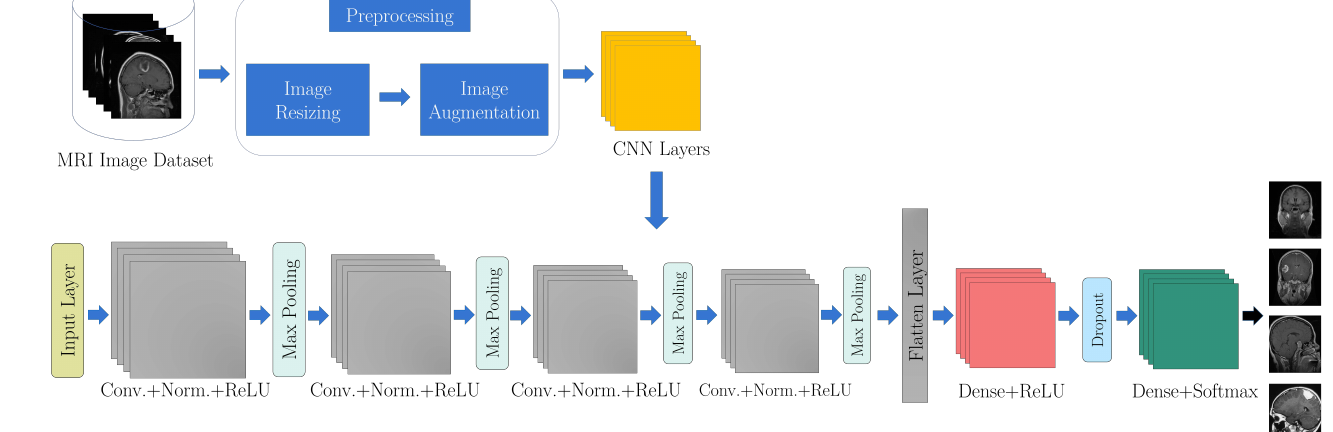
Figure 2. Architecture of the generic CNN model. Input size: 256 × 256. Model: four convolutional layers, with batch normalization, ReLu activation function, and max-pooling layers, applying at the end of the dense stage a Dropout of 0.5 and a dense layer with softmax activation leading to a classification into one of the four possible output labels.